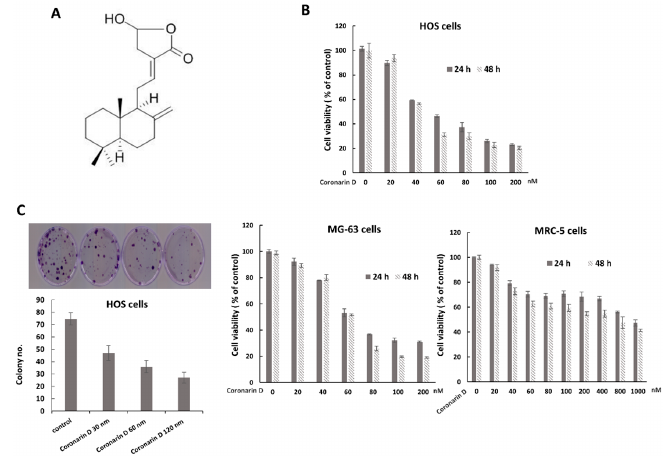
Figure 1. Coronarin D inhibits cell viability of osteosarcoma. ( A ) The chemical structure of coronarin D. ( B ) Coronarin D inhibits osteosarcoma cell growth in a dose- and time-dependent manner. MTT assays were performed with osteosarcoma HOS and MG-63 cells, or human fibroblast cell line MRC-5 exposed to coronarin D in the indicated concentations. Data are expressed as mean ± SD of three independent experiments. ( C ) Coronarin D reduces colony formation of osteosarcoma. HOS cells were plated in colony formation assays after treatment with coronarin D for 6 h. Five-hundred cells were plated per dish. All experiments were performed in triplicate, and the figure above shows a representative